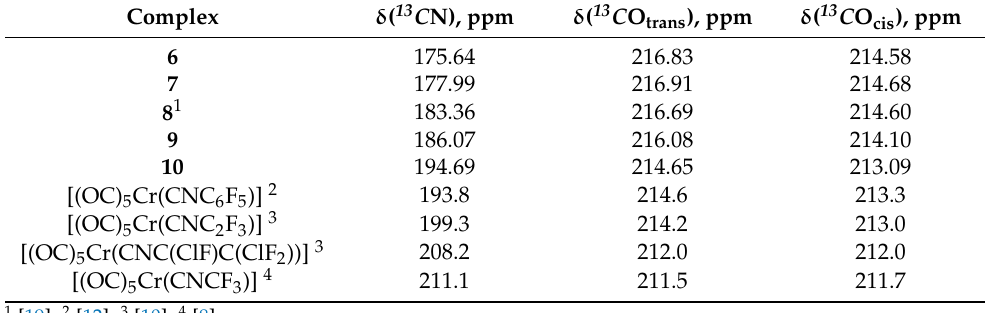
Table 5. 13 C NMR data for the [(OC) 5 Cr(CN)] core in complexes [(OC) 5 Cr(CNR)] dissolved in CDCl 3 .